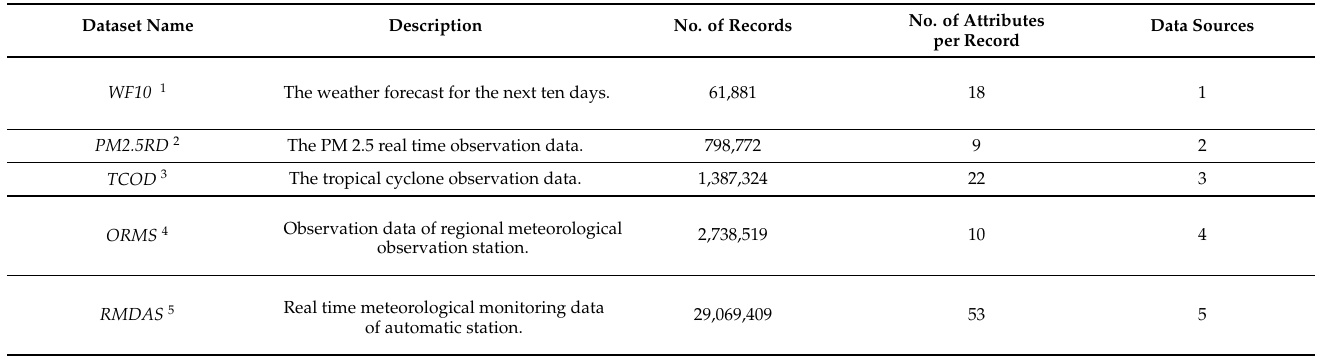
Table 2. Details of experimental datasets, which were accessed on 25 July,